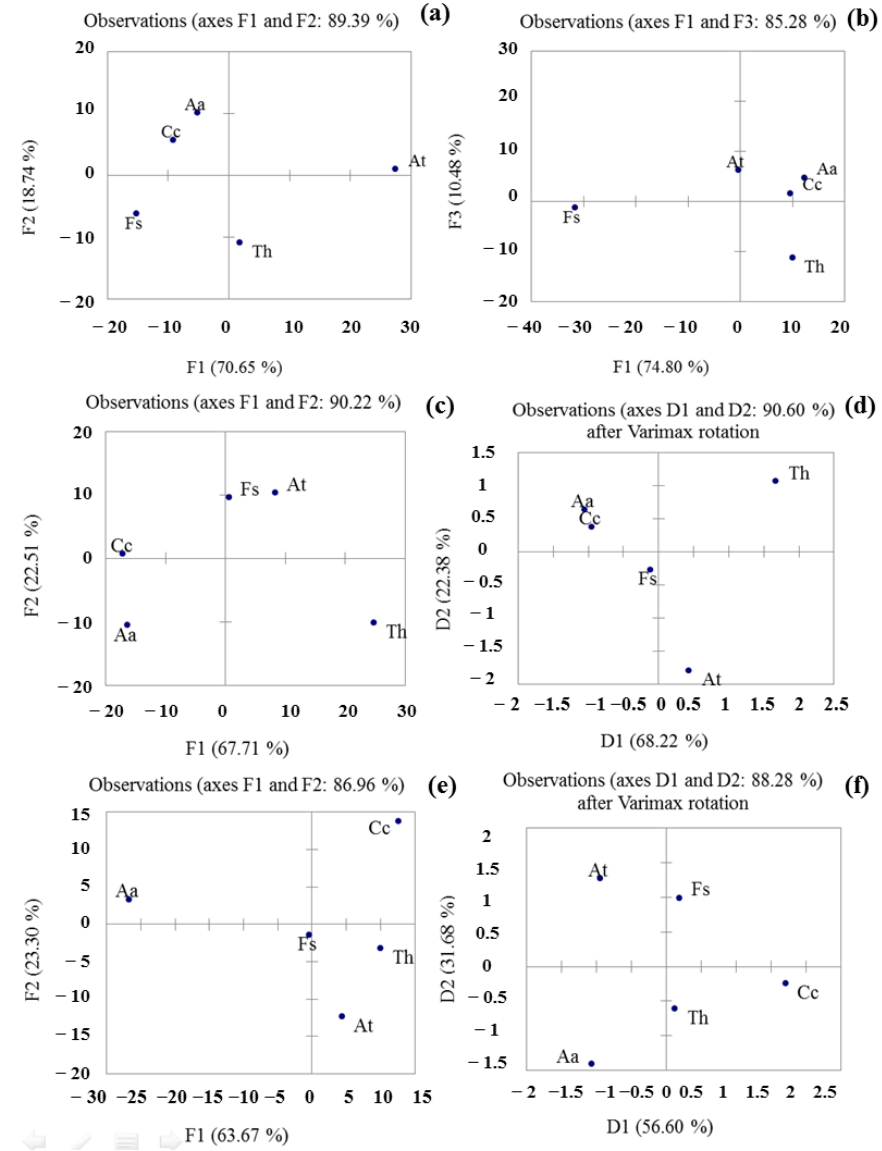
Figure 5. Discrimination of fungal samples with PCA: fluorescence data at excitation at 280 nm (( a ) liquid medium; ( b ) agar medium); at 310 nm (( c ) liquid medium; ( d ) agar medium), at 370 nm (( e )—liquid medium; and ( f )—agar medium).